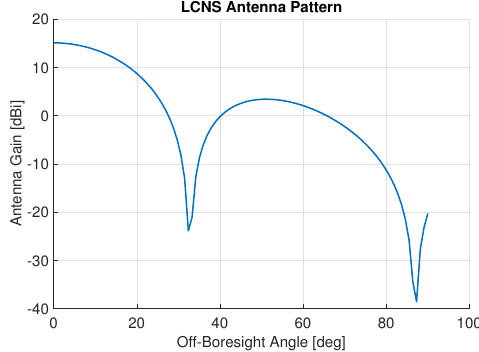
Figure 4. Antenna pattern of the LCNS